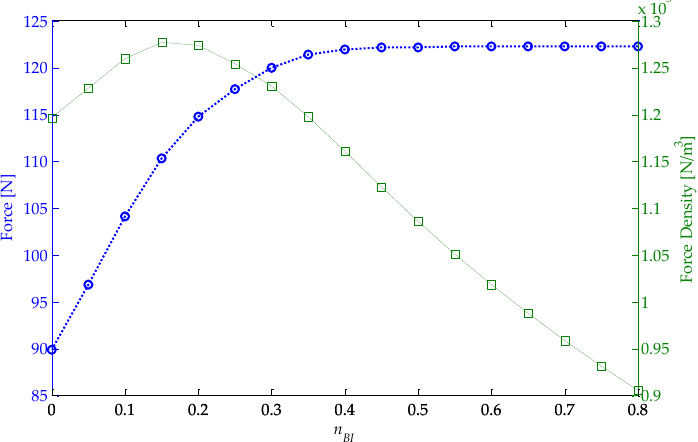
Figure 17. Force and force density of the final actuator design as a function of the parametric variable n BI obtained with nominal effective current density.